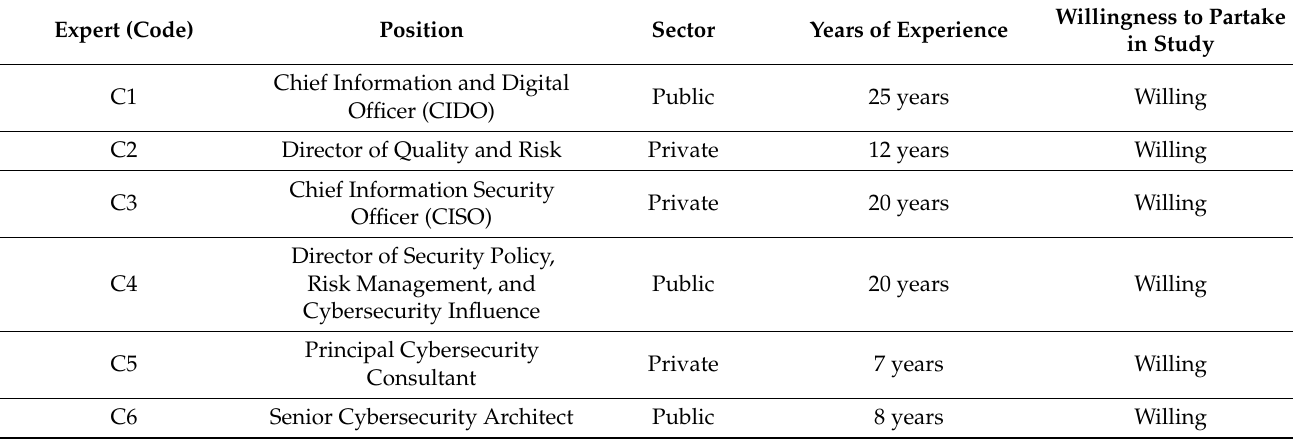
Table 3. Profile of the